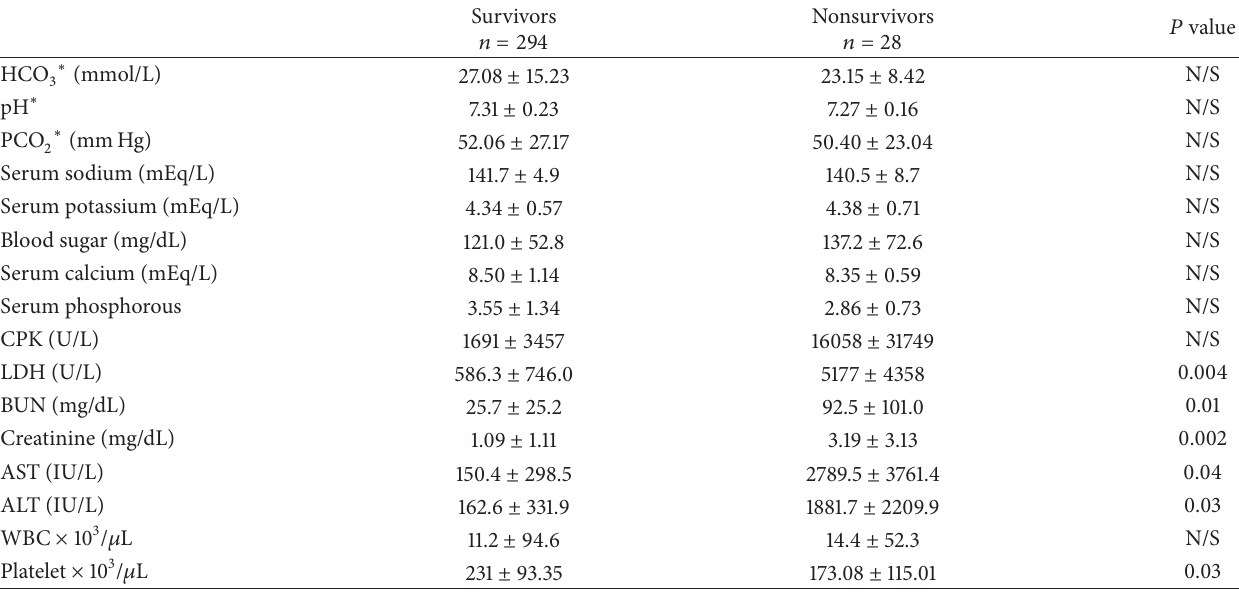
Table 2: Laboratory findings in survivors and nonsurvivors (mean ± SD).